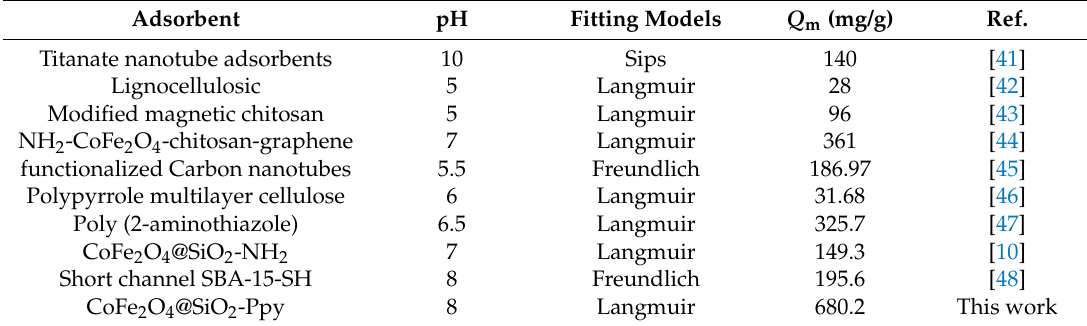
Table 4. Comparison of Hg 2+ removal capability.